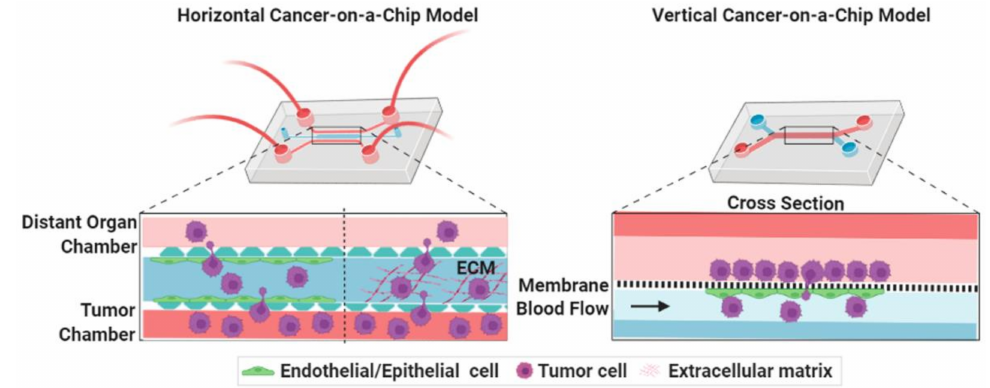
Figure 2. Simple representative microfluidic-based cancer-on-a-chip models show the movement of cancer cells from its site of origin to the distant organs. Microfluidic-based cancer-chips models are grossly classified into two types: horizontal and vertical chips. In horizontal cancer chip models (such as microvascular network (MVN) chip), the chambers are walled off by micron-sized pillars, which creates separate compartments for growing different cell types in their own zone without mixing with each other during the initial seeding but allow cellular interactions via paracrine, juxtracrine, or mechanical fashion. In vertical chips, the channels are separated by a membrane that may represent both cancer intravasation and extravasation process. In some cases (such as ovarian TME organ-on-a- chip (OTME)), a vertical layer can be integrated with the horizontal chips to mimic a more complex tumor